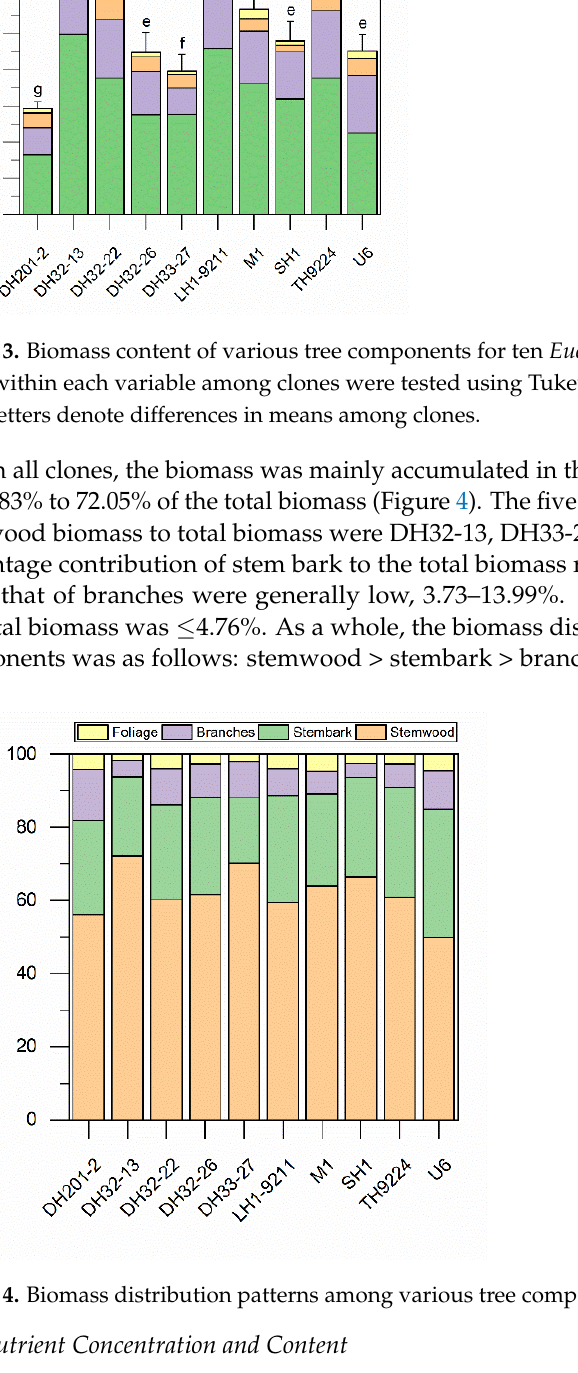
Figure 4. Biomass distribution patterns among various tree components for ten Eucalyptus Clones.